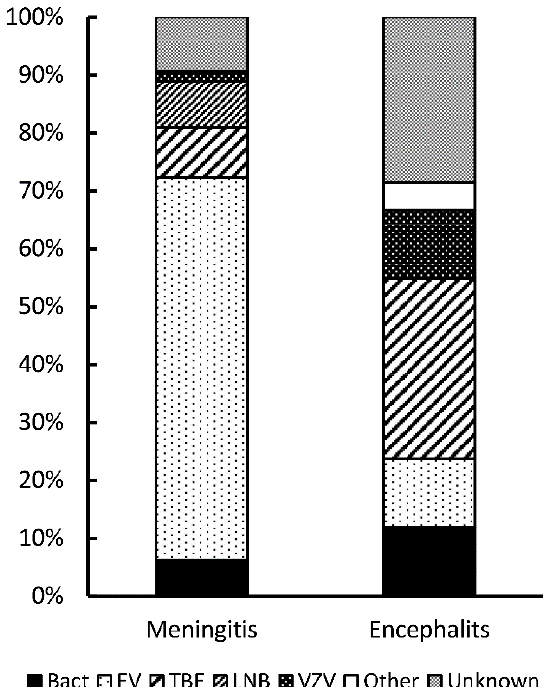
Figure 1. Etiology of infectious meningitis and encephalitis in children included in the study. Abbreviations: Bact: bacterial; EV: enteroviral; TBE: tick-borne encephalitis; LNB: Lyme neuroborreliosis; VZV: varicella zoster virus.